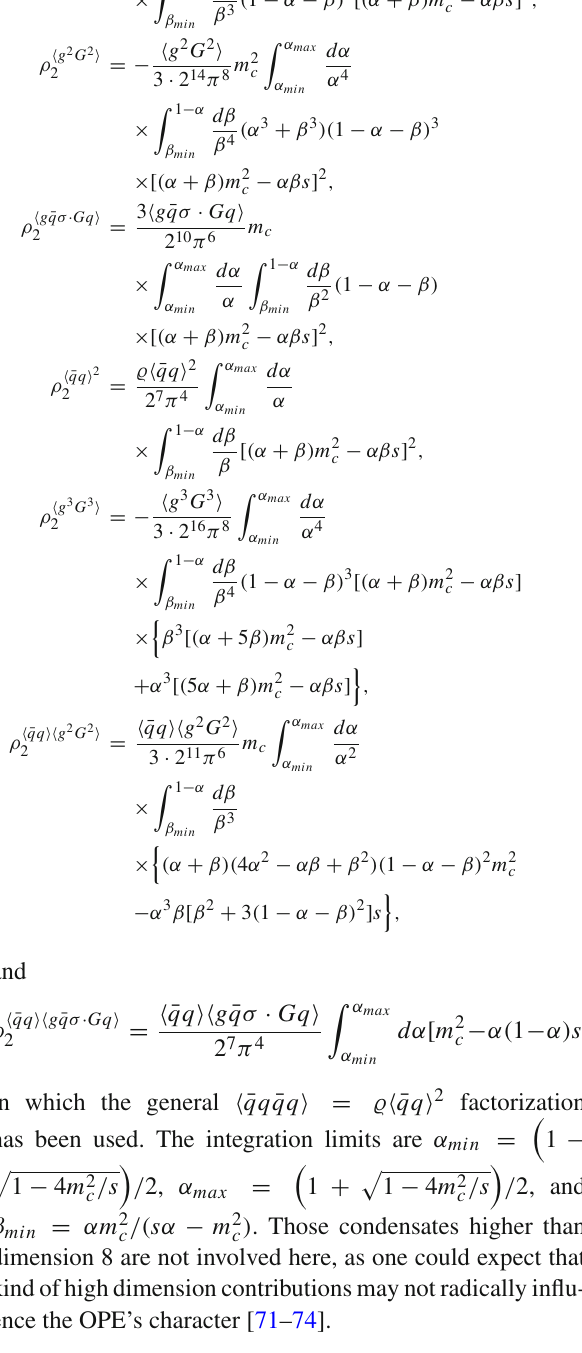
Fig. 1 The relative contributions of various OPE as a function of M 2 √ s 0 = 4 . 8 GeV for (cid:2) c ¯ D in sum rule (6) for